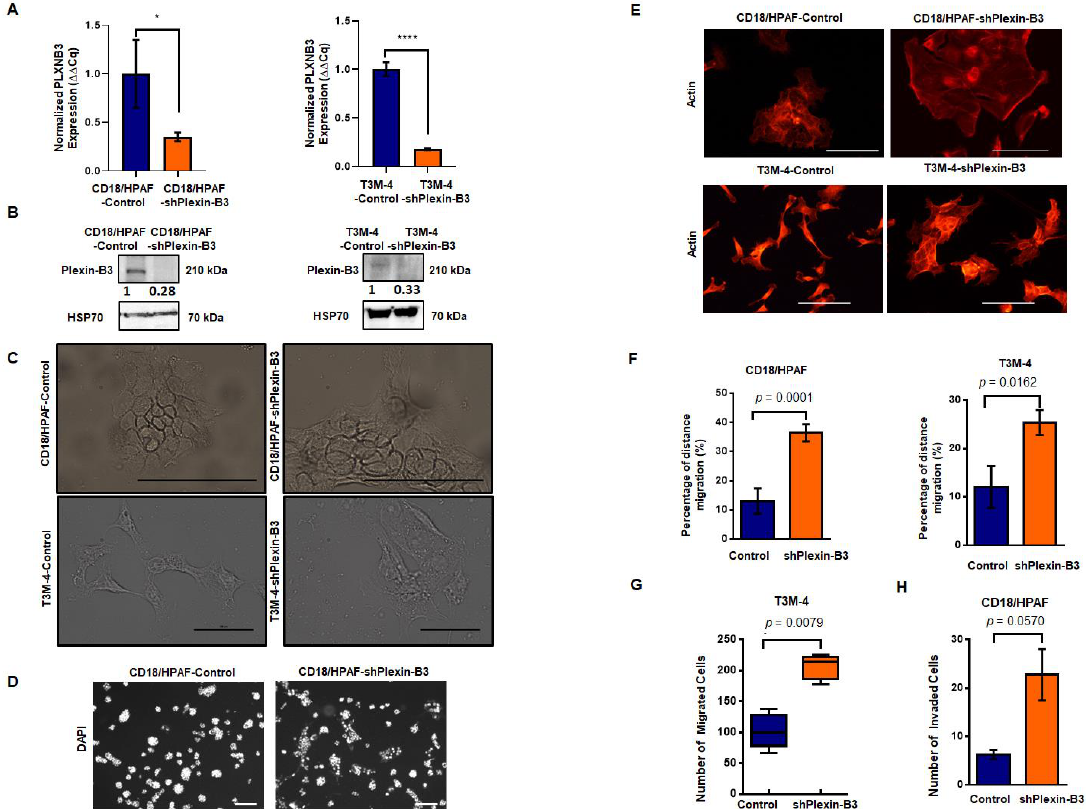
Figure 3. Knockdown of Plexin-B3 leads to a change in cellular morphology and increased cellular motility and invasiveness of PC cells. ( A ) Bar graph showing the relative fold decrease in mRNA expression of PLXNB3 in CD18/HPAF- and T3M4-shPlexin-B3 samples compared with their respective controls. HPRT (hypoxanthine-guanine phosphoribosyltransferase) is used as a control. The values are the mean relative fold changes ± standard error of the mean (SEM, bars). ( B ) Western blot analysis of whole-cell lysates of CD18/HPAF-and T3M-4- and control and Plexin B3 knockdown cells. The Plexin-B3 expression is downregulated in Plexin-B3 knockdown cells of T3M-4- and CD18/HPAF compared to their respective control cells. ( C ) Representative images of the morphology of CD18/HPAF control and Plexin-B3 knockdown cells and T3M-4- Control and Plexin-B3 knockdown cells. Images show morphological differences with an increase in cellular area with the knockdown of Plexin-B3. The scale bar represents 100 µ m. ( D ) Representative images of colonies formed by CD18/HPAF-Control and CD18/HPAF-shPlexin-B3 cells in a three-dimensional Matrigel matrix. Images show stained nuclei (DAPI) of the cells in a colony, demonstrating a lack of CD18/HPAF Plexin-B3 cell ability to form dense colonies in comparison with their respective control cells. Images are taken at 100 × magnification using a Life EVOS FL fluorescence microscope. ( E ) Representative images of the actin cytoskeleton in CD18/HPAF-Control and shPlexin-B3 and T3M-4-Control and T3M-4-shPlexin-B3 cells showing remodeling of the actin cytoskeleton. The scale bar represents 100 µ m in length. ( F ) Bar graphs showing a higher in vitro migration of Plexin-B3 knockdown cells in CD18/HPAF ( p < 0.0001) and T3M-4 ( p = 0.0162) in comparison with their respective control cells using a wound scratch assay. The values in the graph represent the percentage of distance migration, and the error bars represent the SEM. The statistical p -value was calculated using a Student’s t -test. ( G ) Box plot analysis shows a higher in vitro migration of Plexin-B3 knockdown cells in T3M-4 ( p = 0.0078) compared to the control cells using the Transwell migration assay. The values represent the number of migrated cells, and error bars in the box plot represent the SEM. The statistical p -value was calculated using a nonparametric Mann–Whitney U Test. ( H ) Bar graph showing the number of invaded cells in the control and Plexin-B3 knockdown in CD18/HPAF cells. Bar graphs show a higher number of cells invading through the matrix in CD18/HPAF-Plexin-B3 ( p = 0.057) knockdown cells compared to their respective control cells. The values in the graph represent the number of invaded cells, and the error bars represent the SEM. The statistical p -value was calculated using a nonparametric Mann–Whitney U Test. (* p ≤ 0.05, and **** p ≤